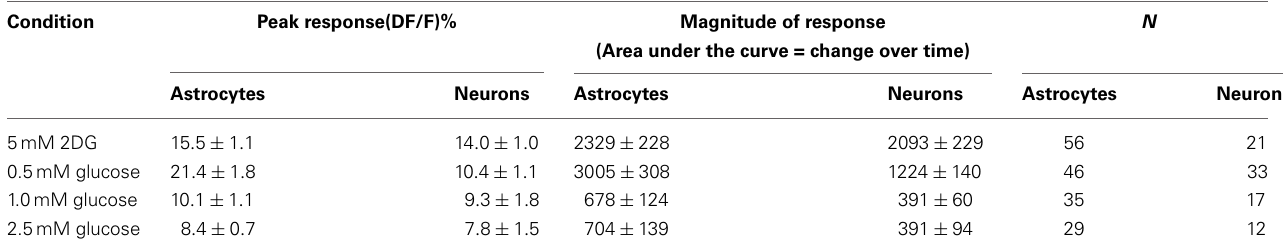
Table 2 | Response parameters of NST astrocytes and neurons responsive to low-glucose or 2DG conditions.